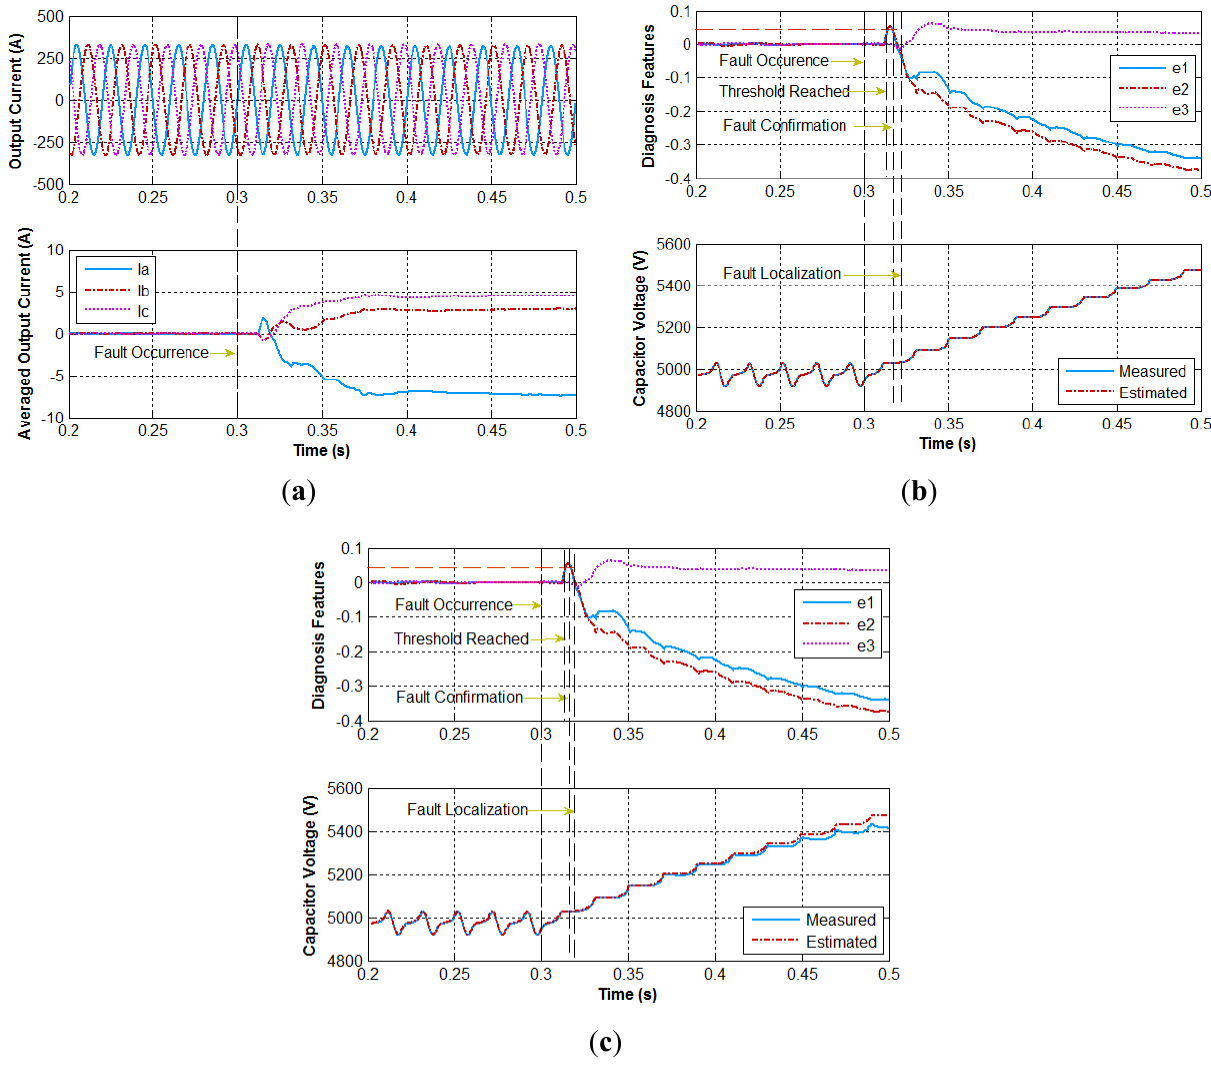
Figure 11. Open-circuit fault in T 1 under 10MW. ( a ) Output current and their averaged values; ( b ) Diagnosis features and capacitor voltages in SM1; ( c ) Diagnosis features and capacitor voltages in